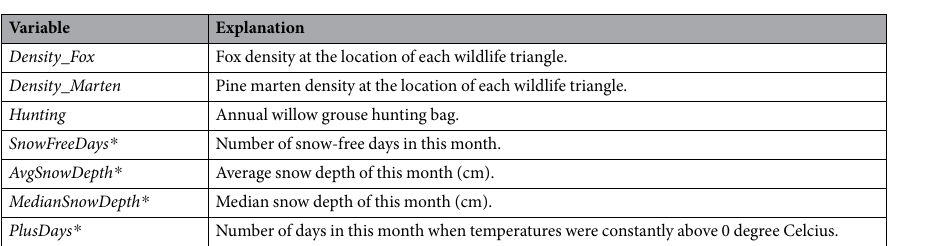
Table 1. The variables included in the selection process. * These variables were tested both from the seasons preceding the August bird census and the seasons two years earlier. The snow- and weathervariables were calculated for all target months (October, November, April,